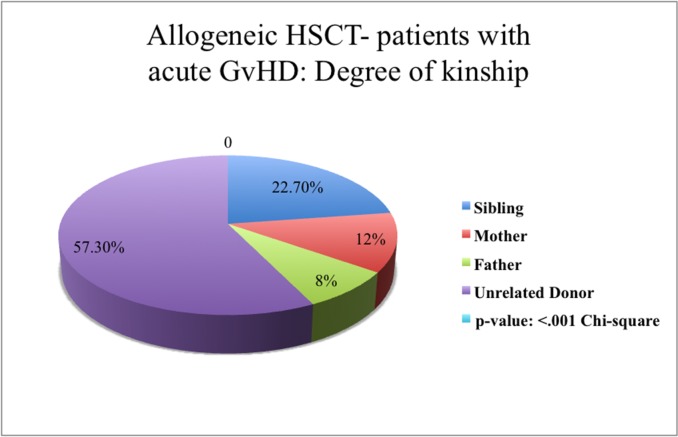
Patients after allogeneic HSCT with acute GvHD.Stated the degree of kinship between donor and receiver of stem cells. The distribution of degree of kinship across all patients in the allogeneic patient group occurred acute GvHD is displayed as a pie chart. Statistical significant difference p < .001Chi2.